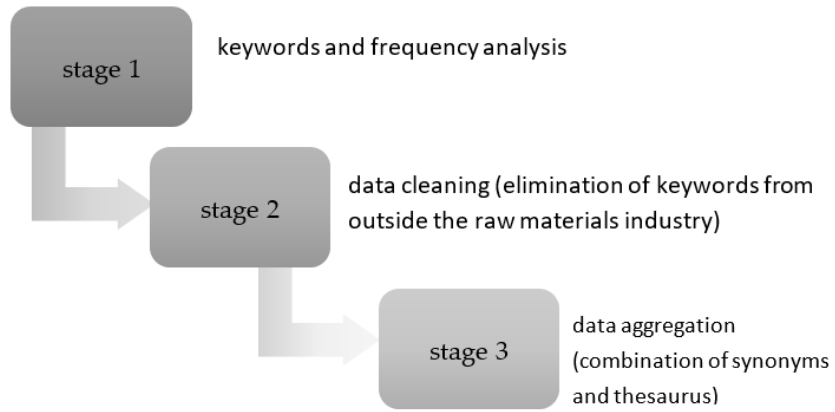
Figure 3. Research work stages in determining the market gap in the raw materials sector (own study). Table 1. Matching keywords with relevant categories from the NACE (own